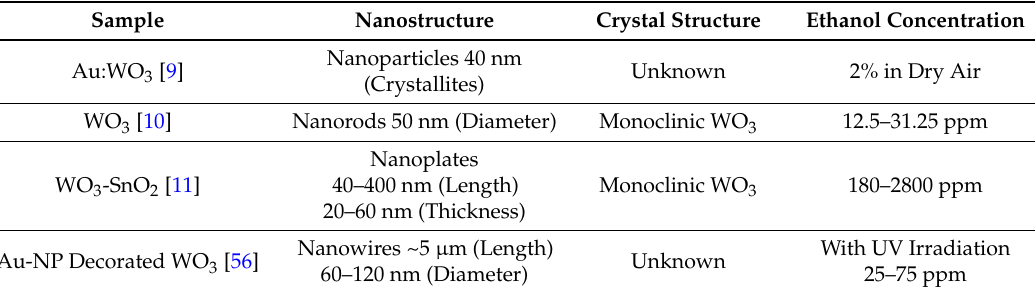
Table 4. A list of different samples used to detect